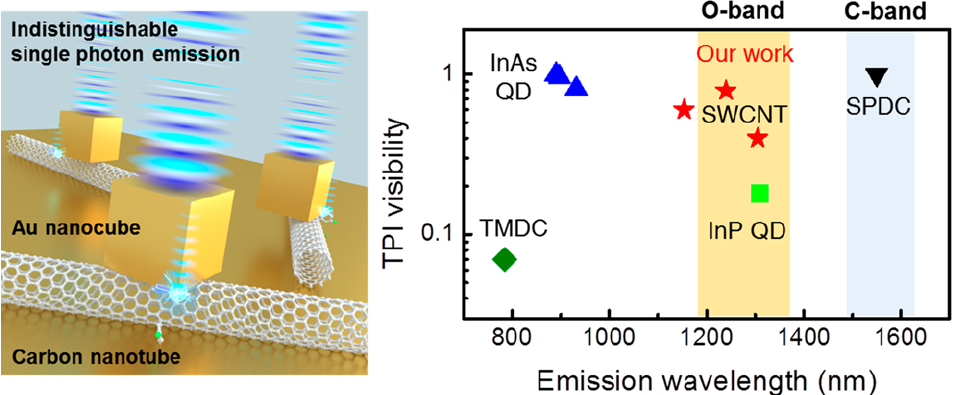
Figure 12. Schematic presentation of carbon nanotube quantum emitter and its emission wavelength band [57].